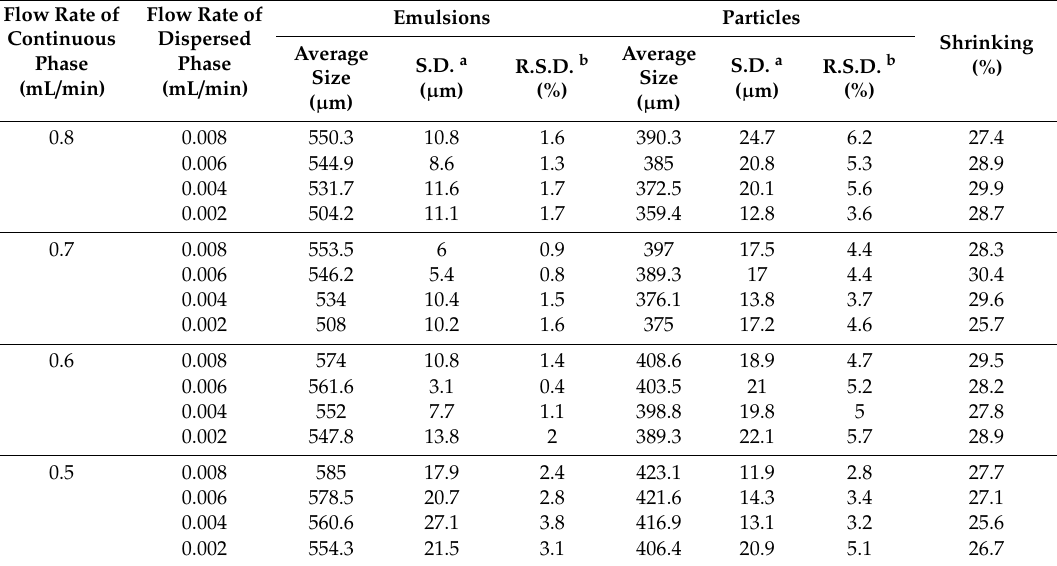
Table 1. The flow rates influence to the diameter of emulsions and